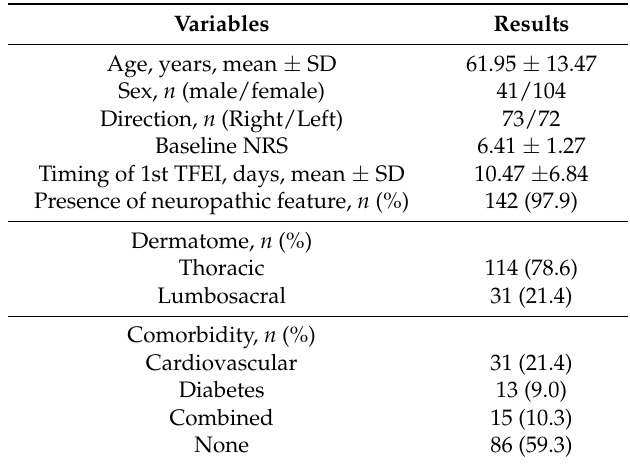
Table 1. Demographic data of